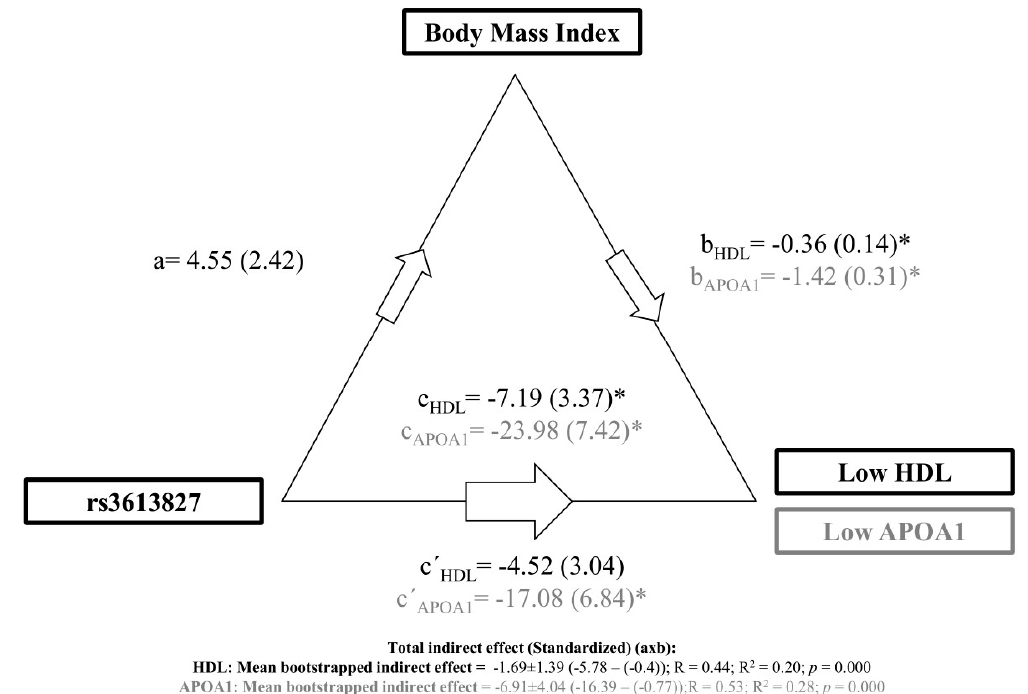
Figure 3. Causal mediation model of the total effect of APOA2 rs3813627 on HDL and APOA1 levels through BMI. The mediation effect of APOA2 rs3813627 risk genotype carriage on low HDL and APOA1 levels through BMI (assessed on the overweight/obese individuals, n = 95 subjects for HDL and n = 65 for APOA1) after adjusting by sex. Path-weights are displayed as beta values with standard errors in brackets. Asterisks indicate significant p -values (* p < 0.05). Significance of the indirect